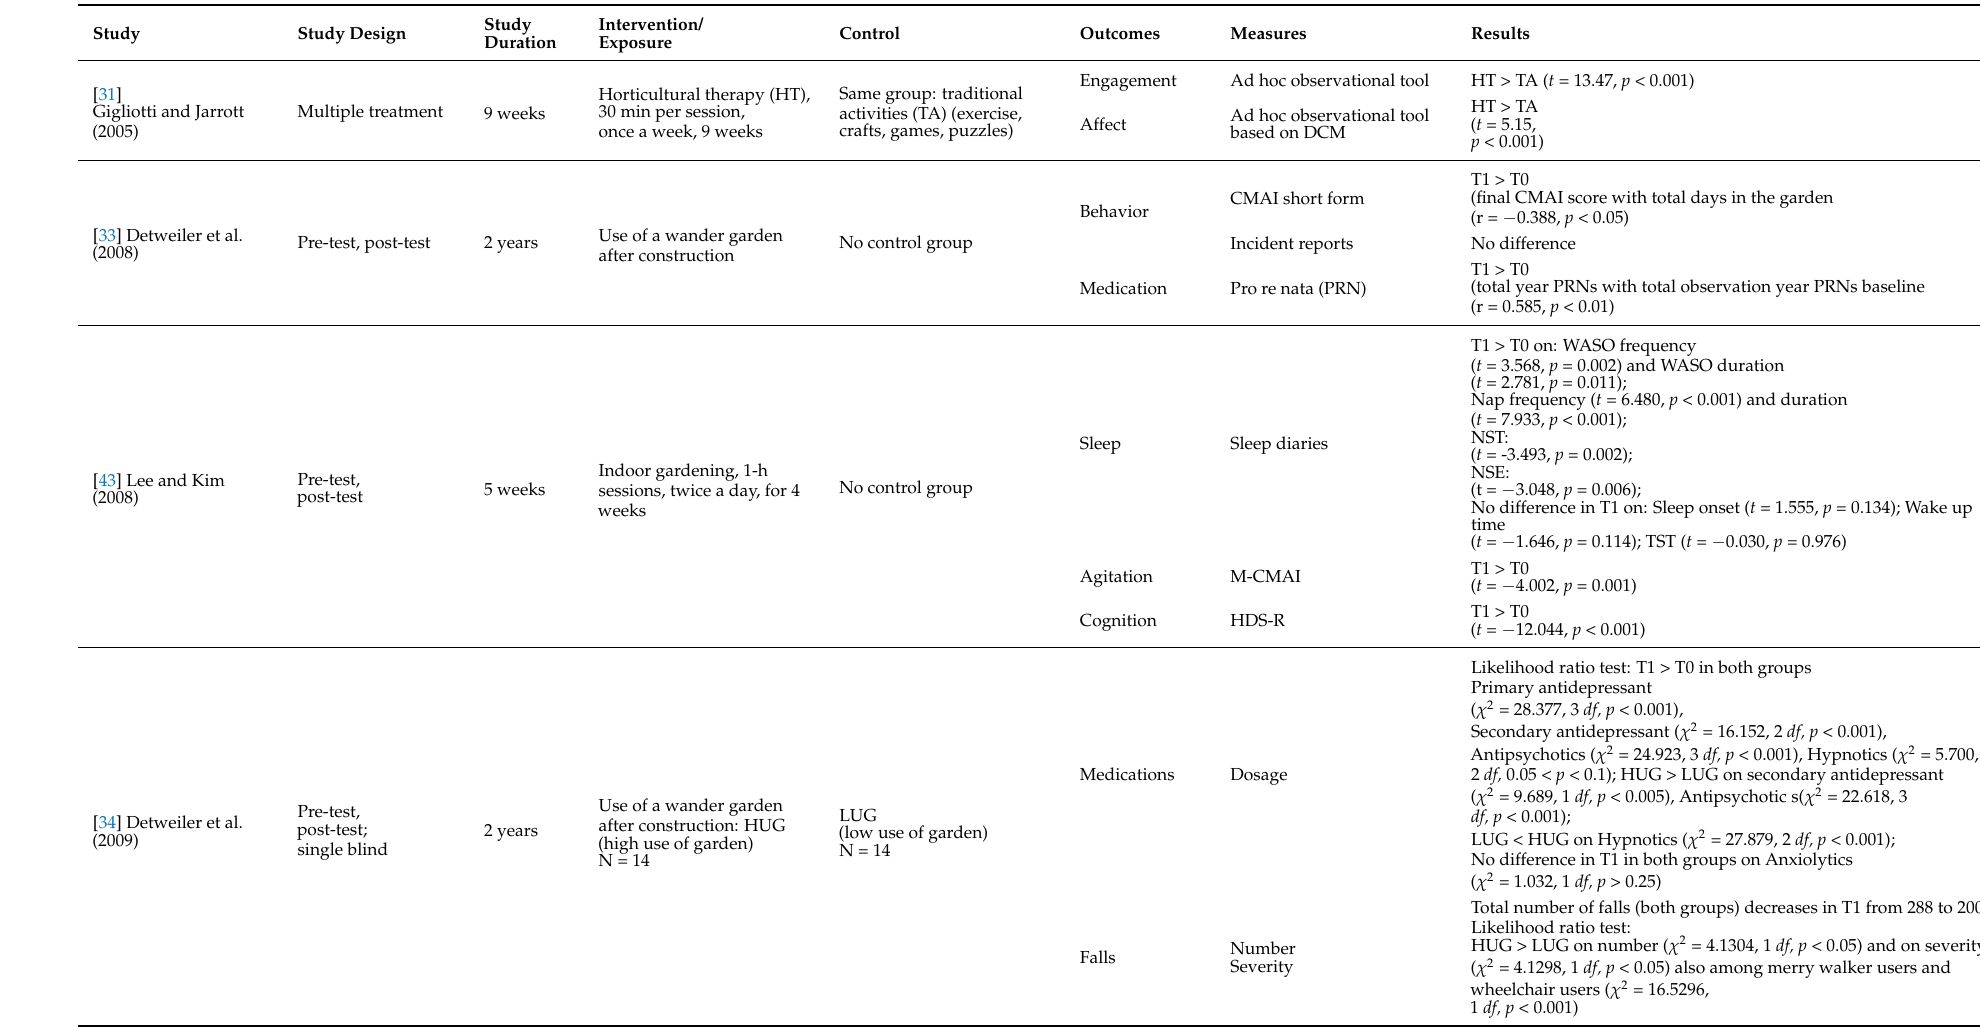
Table A3. Methods and results of the